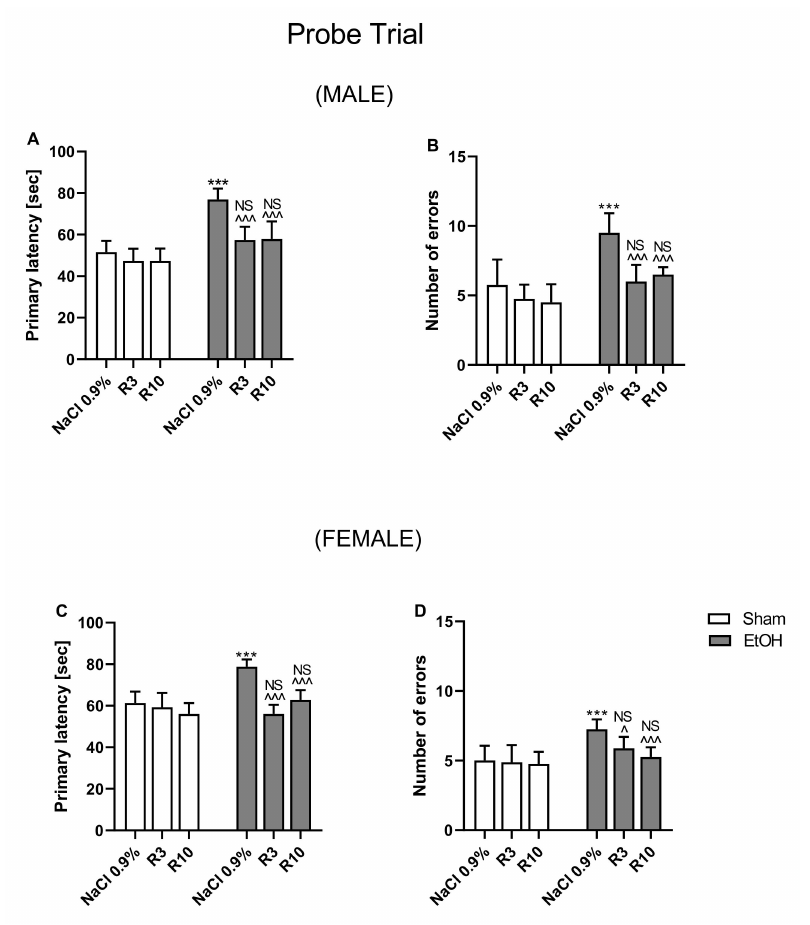
Figure 3. The influence of rapamycin pre-treatment (3 and 10 mg/kg, i.p.) during neonatal